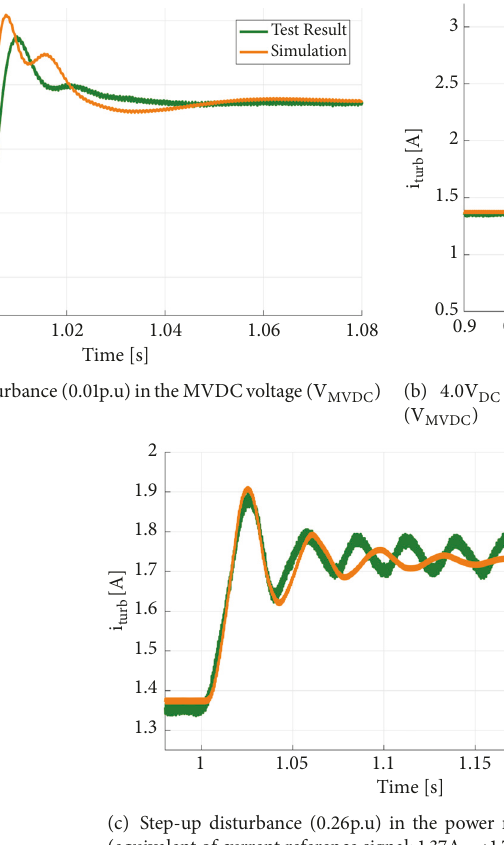
Figure 16: Dynamic response of output current of DC wind turbine converter (i at t =1.0 [ s ]